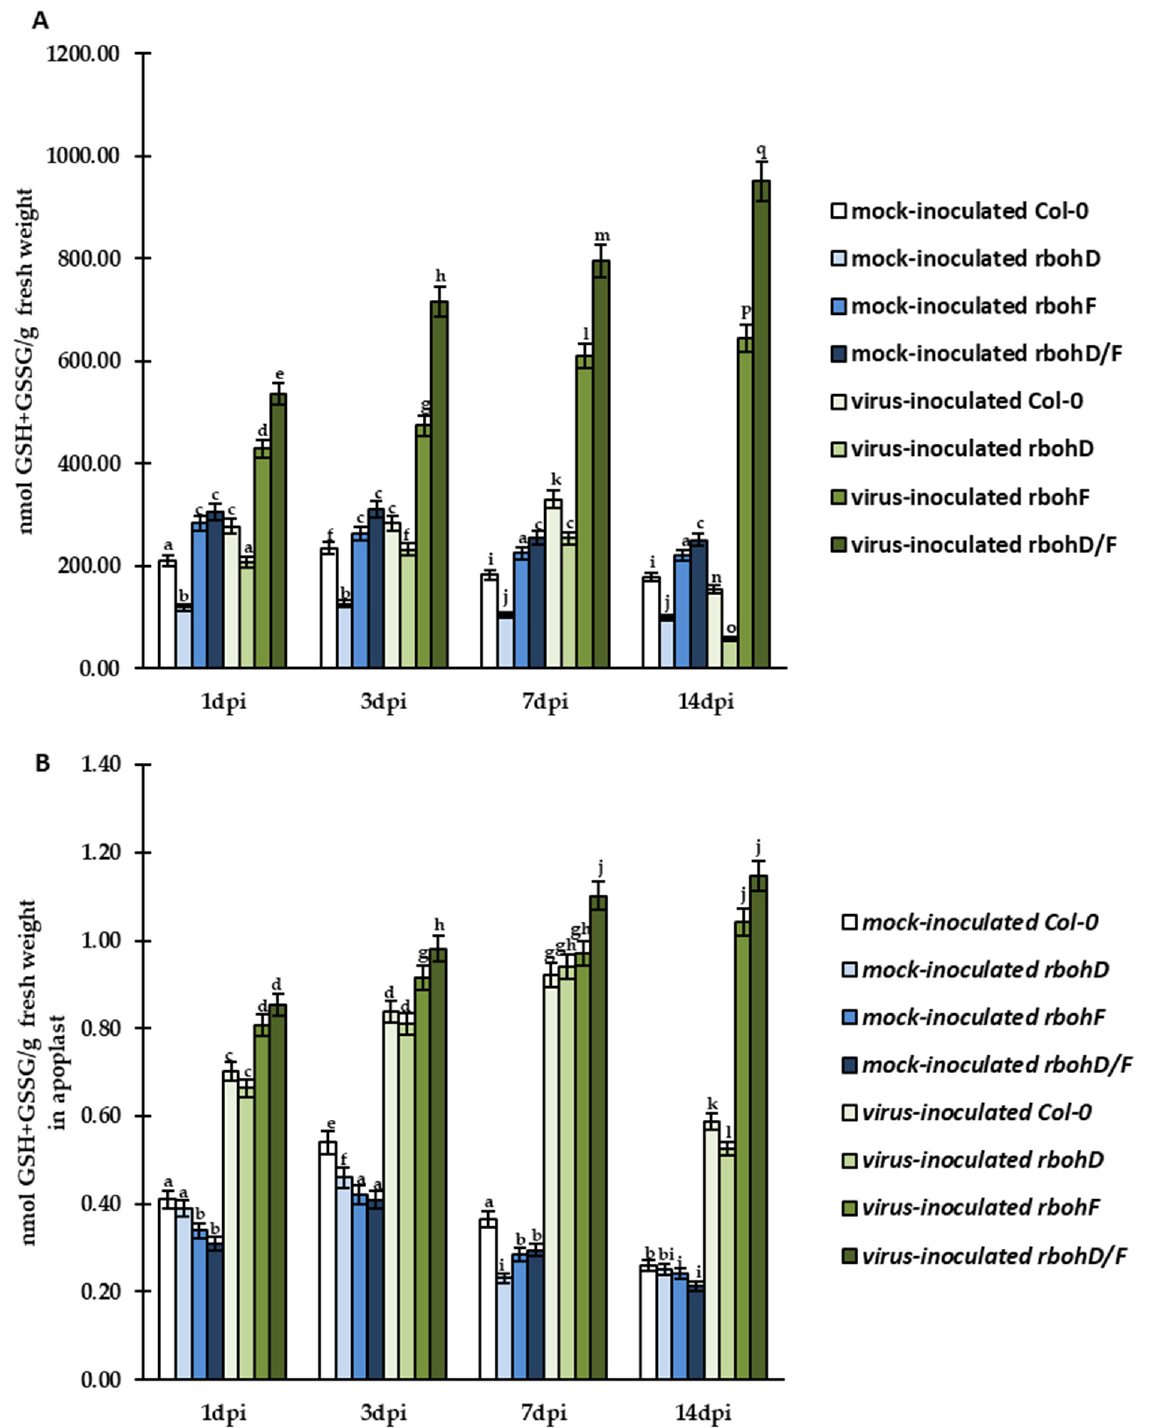
Figure 7. The mean total concentration of GSH and GSSG (GSH+GSSG) in cells ( A ) and apoplast ( B ) in the leaves of TuMV- and mock-inoculated Col-0, rbohD , rbohF , and rbohD/F plants between 1 and 14 dpi. Using ANOVA and Tukey’s HSD test, the mean concentrations of GSH and GSSG were calculated at p < 0.05. Statistically significant values are indicated by different letters above the bars. Further quantitative HPLC analyses confirmed significant and timepoint-specific regu- lation of both glutathione (GSH and GSSG) forms in cells and in the apoplast of Col-0, rbohD , rbohF , and rbohD/F during TuMV infection. During virus infection, we observed